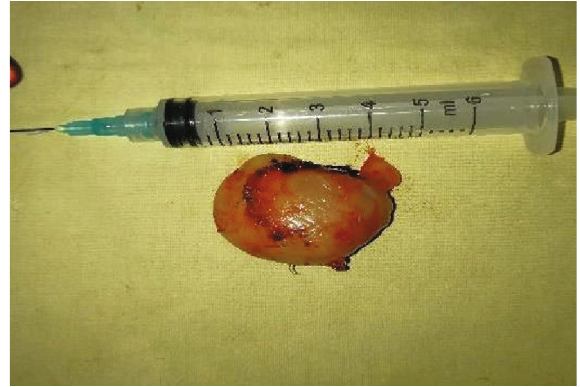
Figure 6: Excised tumour from the base of the